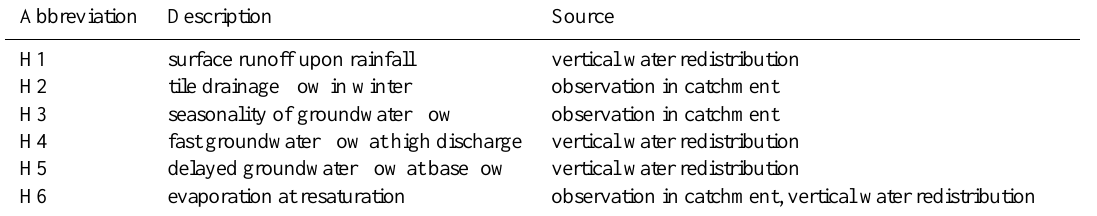
Table 1. Hypotheses for model verification, derived from theory of vertical water redistribution and hydrological processes observed within the catchment.